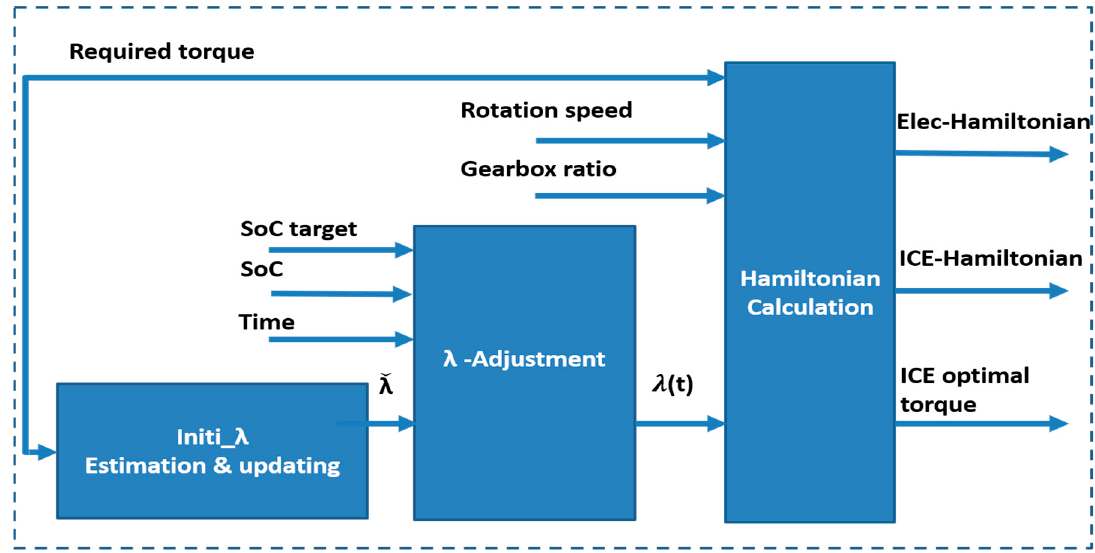
Figure 10. Diagram of an online L-Control calculation.